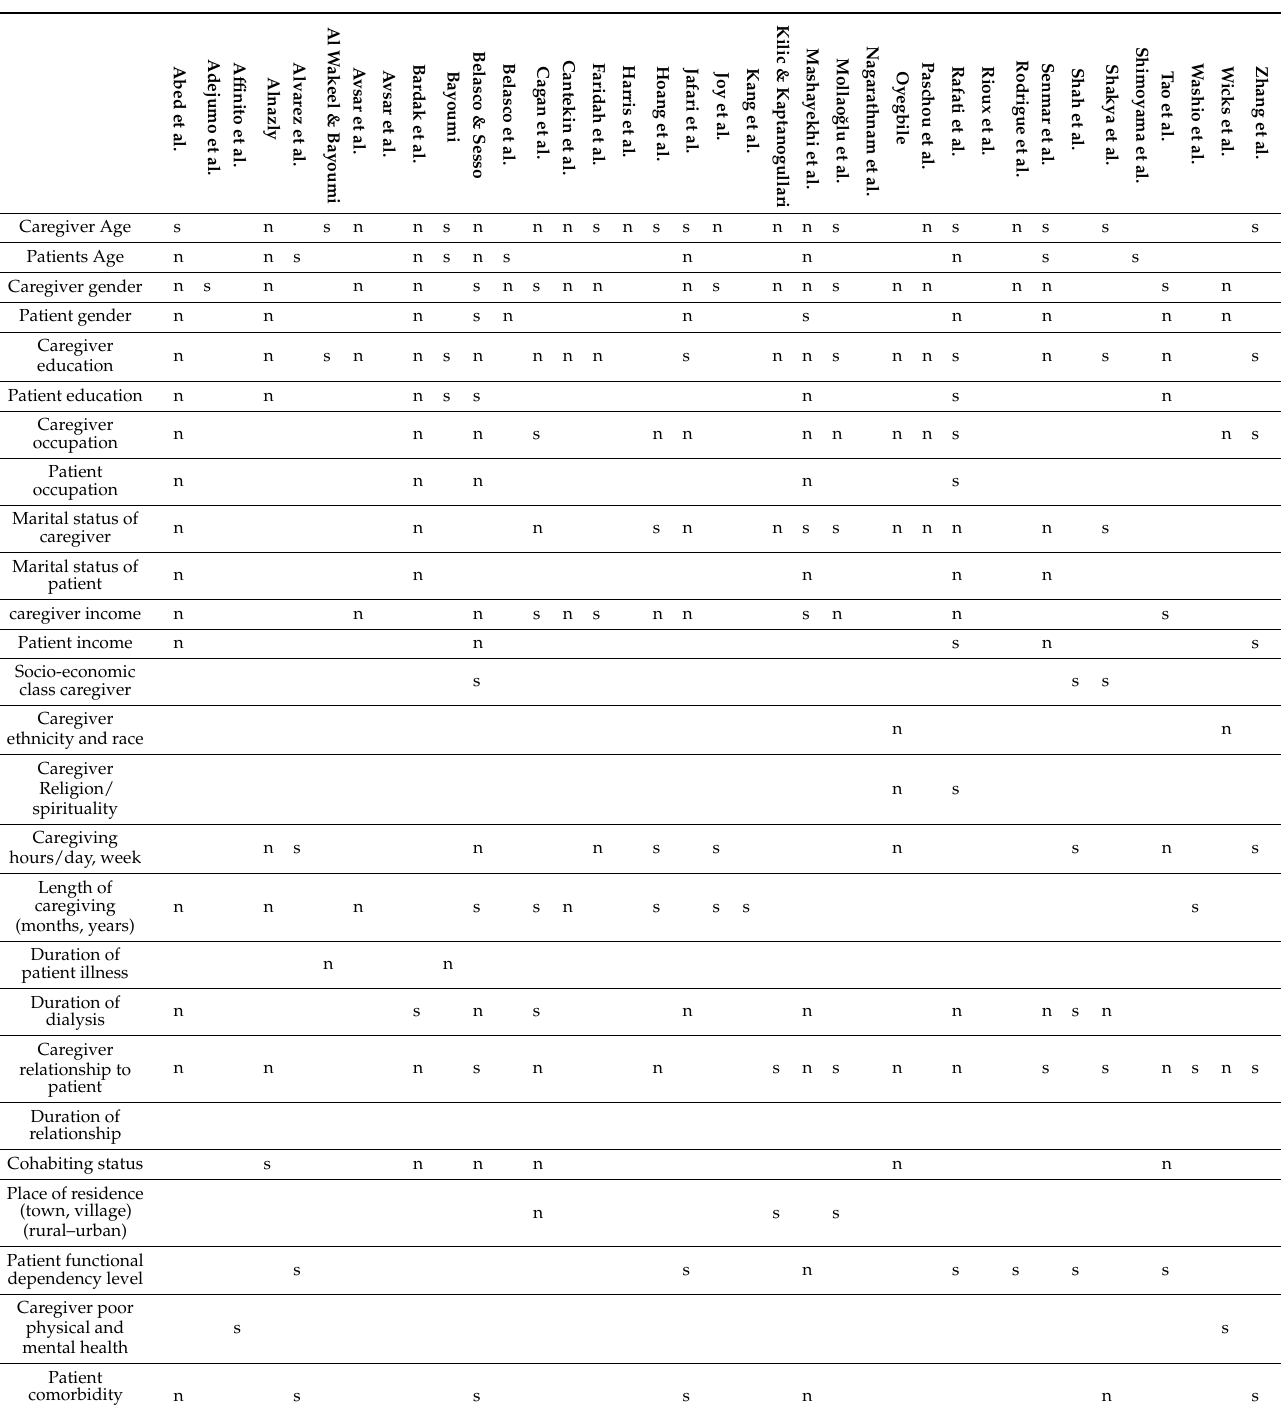
Situational and relational factors including cohabiting status, relationship to the patient, the duration of caregiving, contact time per week, duration of relationship with patients, number of children, smoking and alcohol consumption, and caregiver performing exercise. 5. Psychological factors including depression and anxiety. Table 2. Summarises the factors associated with